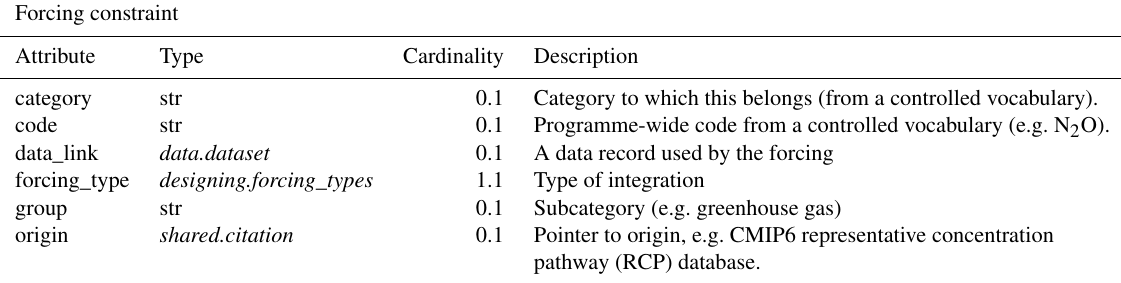
Table 1. ES-DOC controlled structure for describing a forcing constraint: each attribute has a name, a Python data type (those in italics are other ES-DOC types), a cardinality (0.1 means either zero or one, 1.1 means one is required) and a description.